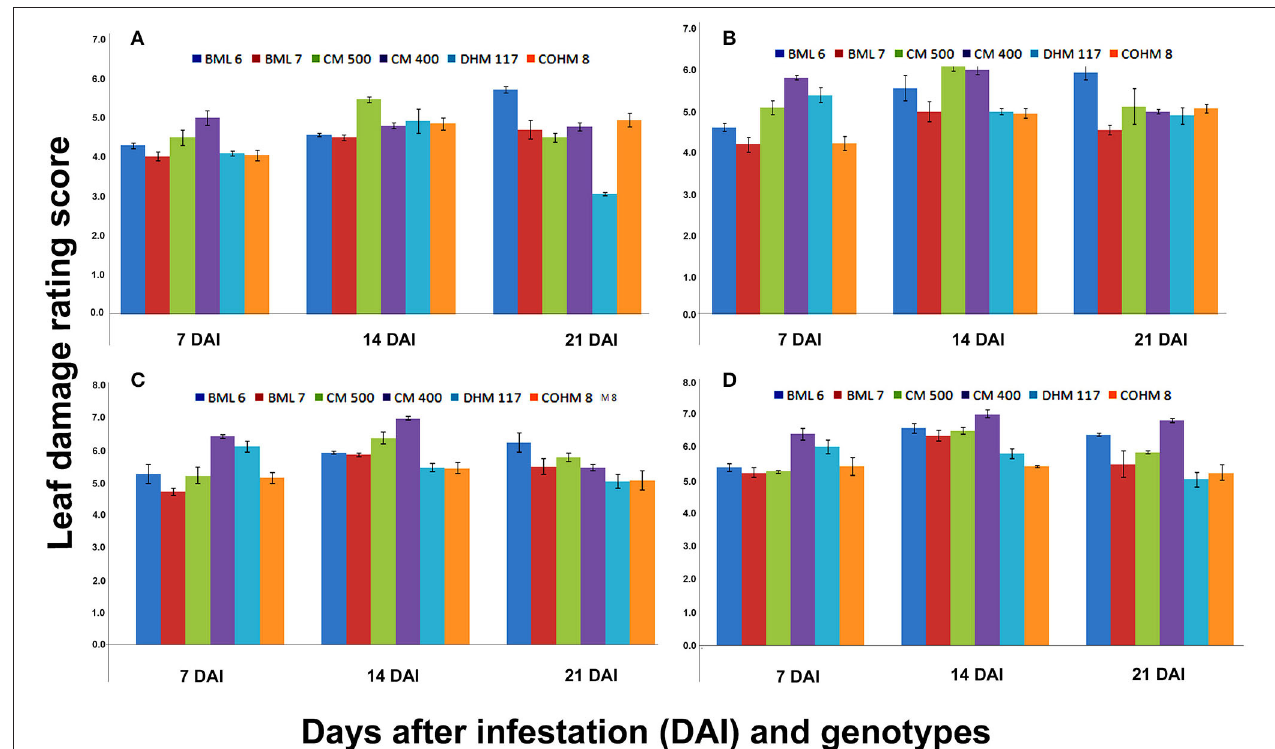
FIGURE 3 | Leaf damage rating (LDR) scores at V 7 phenological stage of maize under artificial infestation in net house conditions at 7, 14 and 21 DAI.